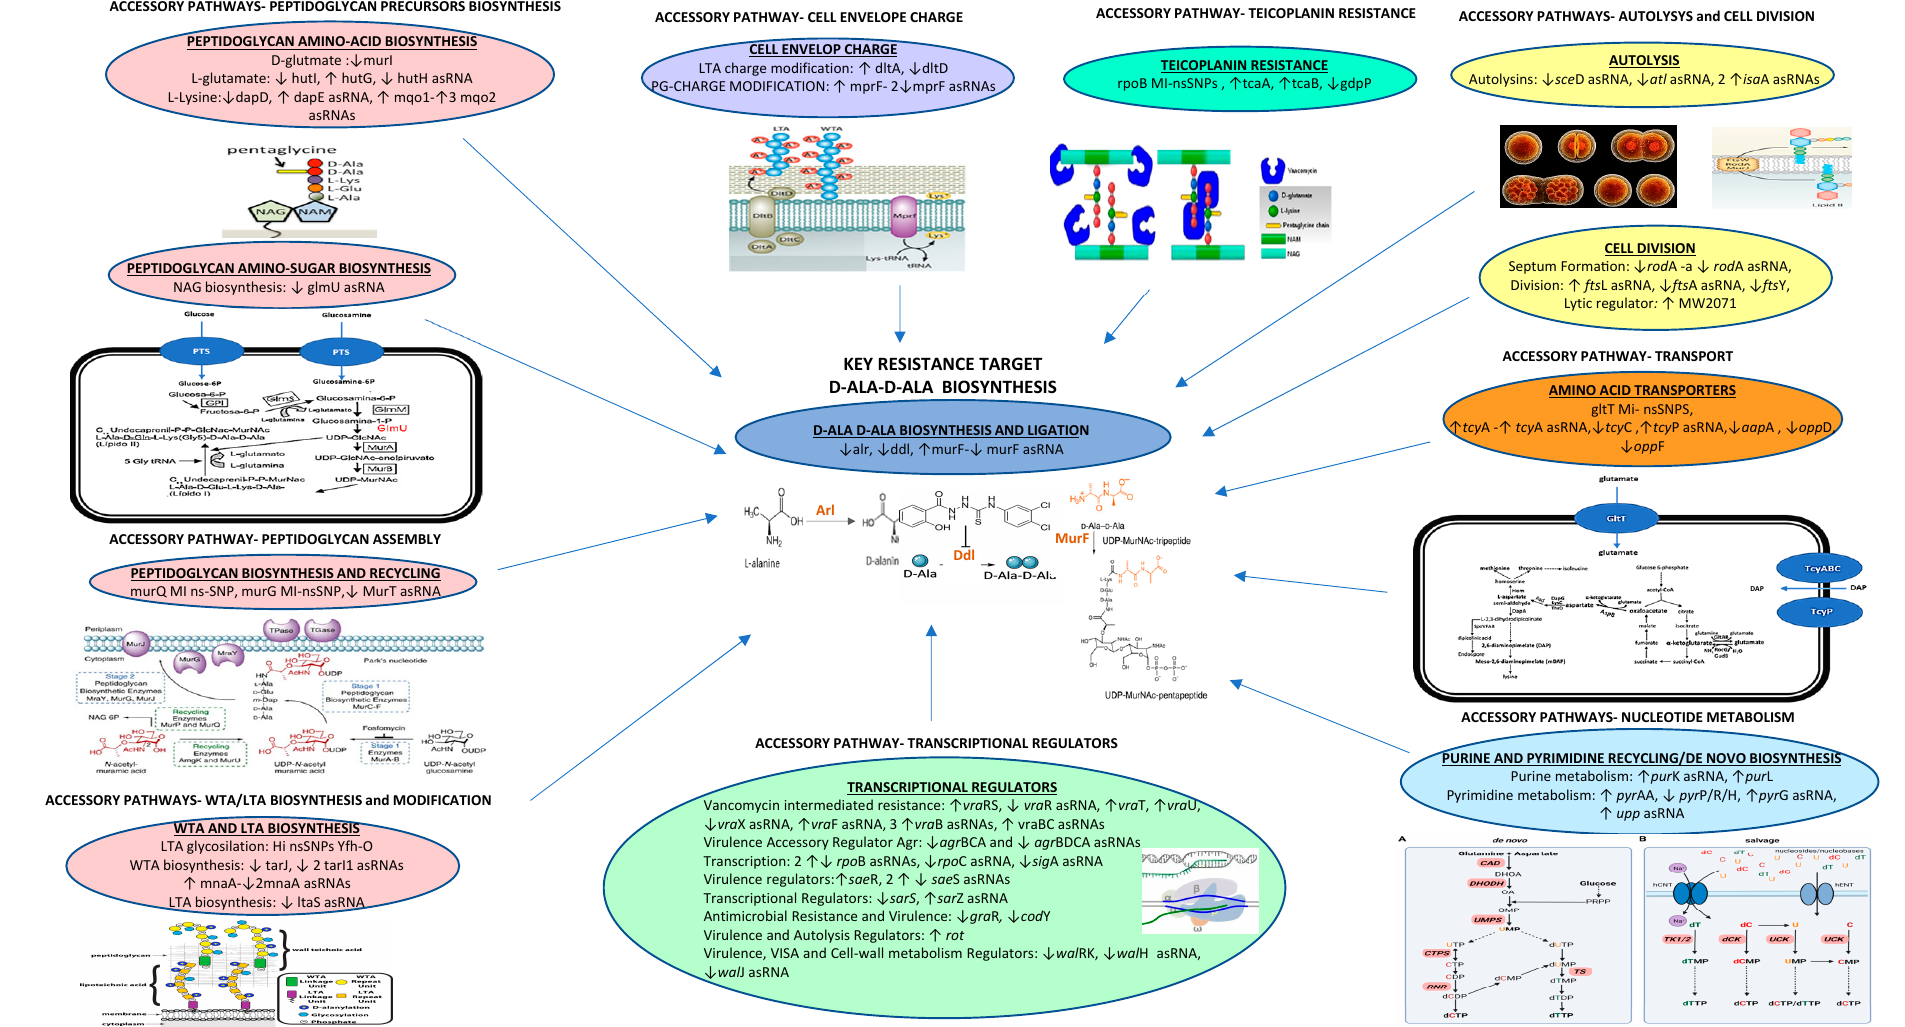
Figure 1. Schematic representation of the affected pathways in VISA CA-MRSA vs. the VSSA CA-MRSA